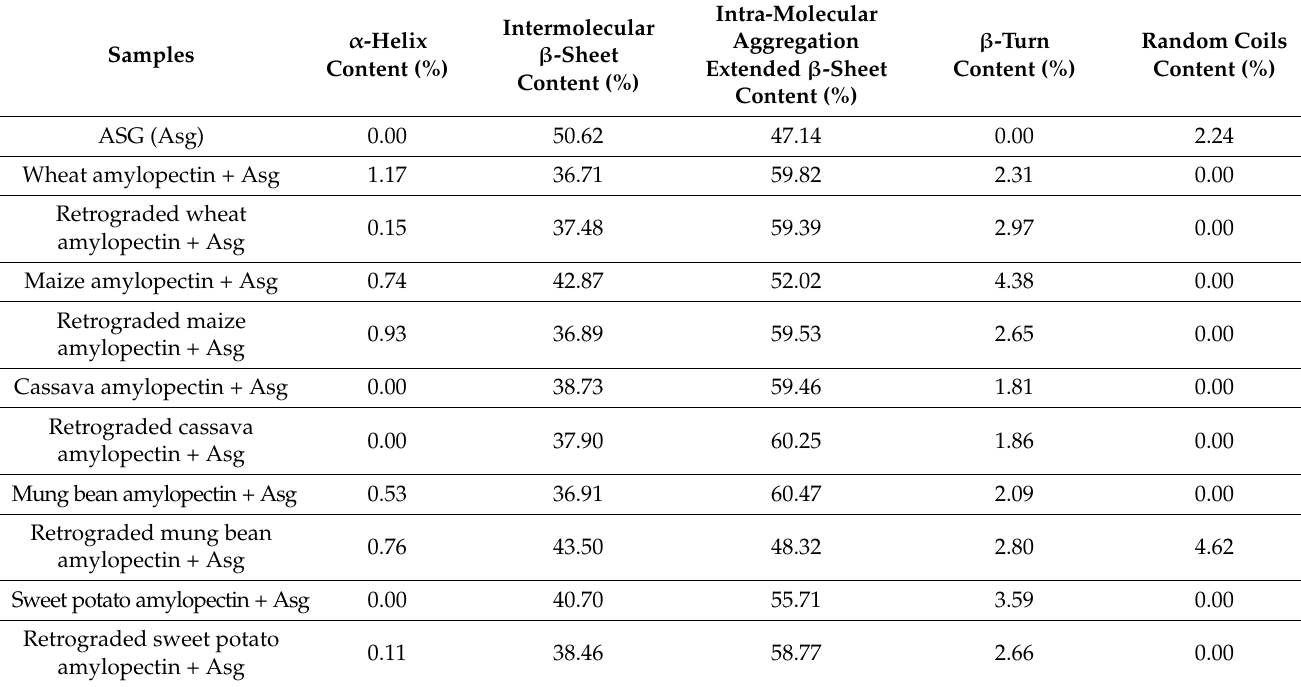
Table 4. The secondary structures of alkali-soluble glutenin mixed with and without different amylopectins before and after